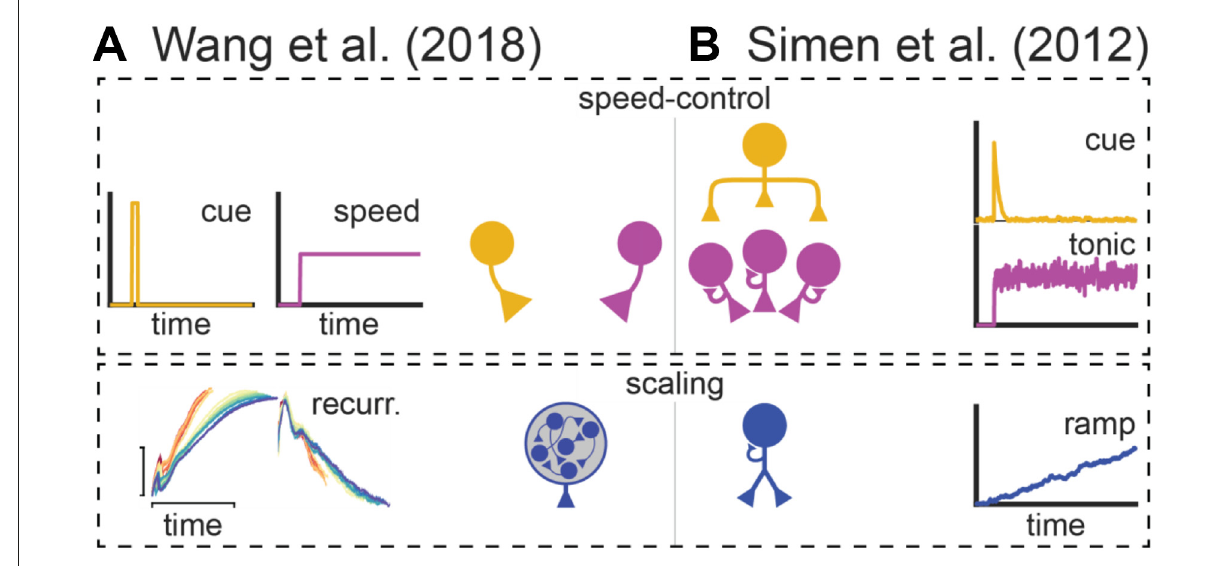
FIGURE9 Speed control across relative population-clock and ramping models. (A) Wang et al. (2018) relative population-clock model as depicted in Figure 8 . (B) Simen et al. (2011) ramping model as described in Figure 3 . Boxes spanning both panels emphasize the conceptual similarities between both models with respect to the speed-control and scaling layers (top and bottom,